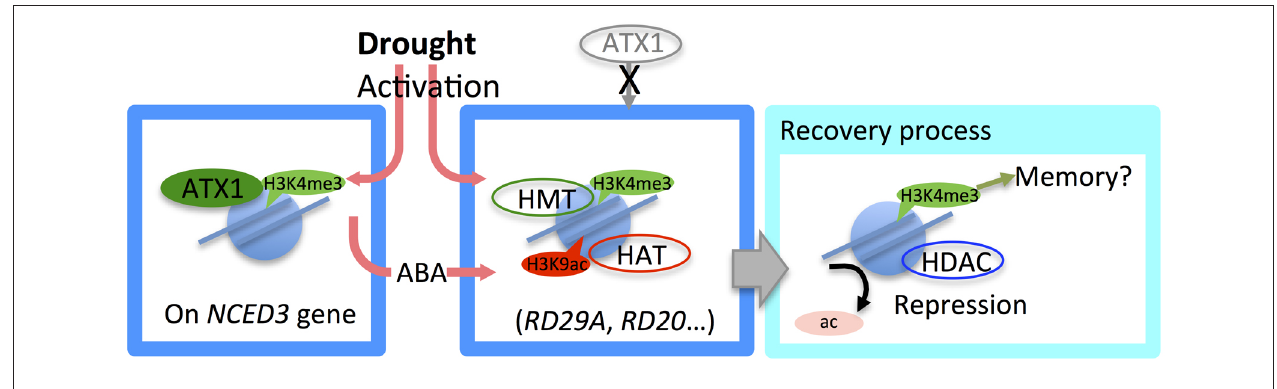
H3K4me3 and H3K9ac were enriched on many drought-responsive genes. During recovery from drought stress, H3K9ac is rapidly removed, while H3K4me3 is removed more slowly, indicating that H3K4me3 may be involved in epigenetic